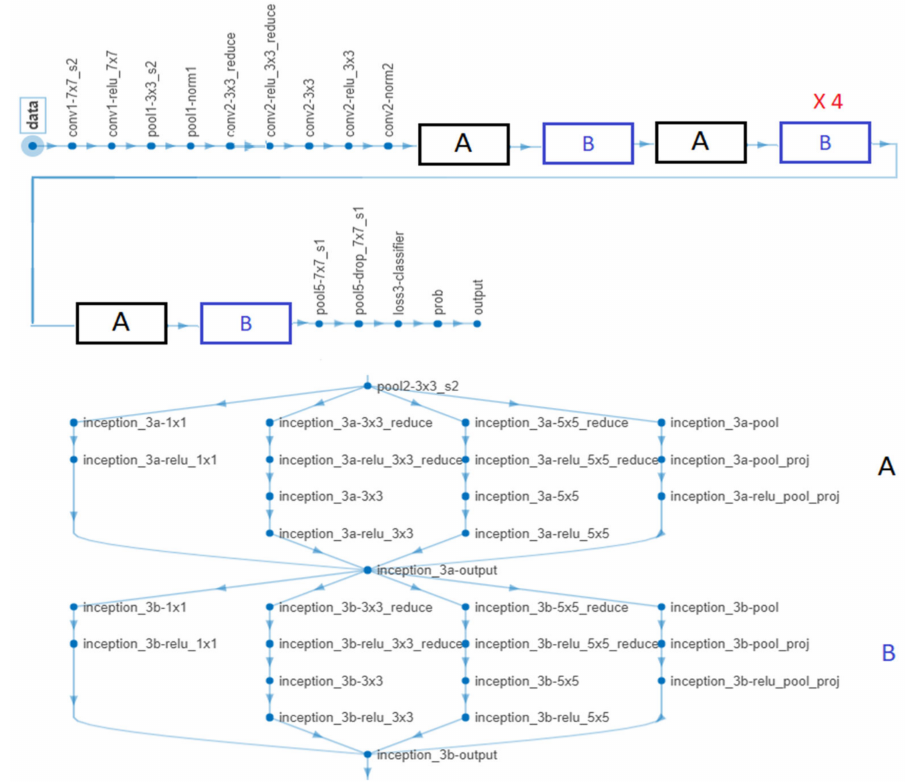
Figure 18. GoogleNet CNN architecture obtained by the help of